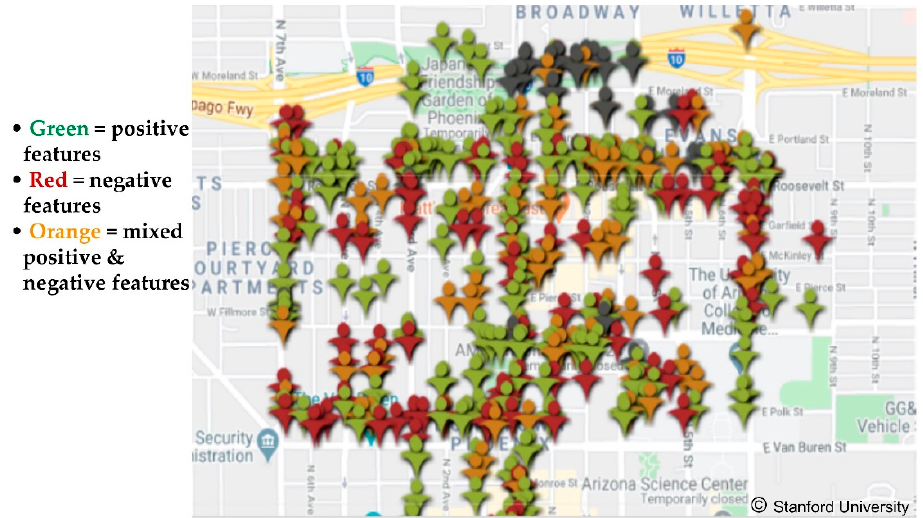
Figure 5. Example of discovery tool geocoded citizen science data grouped by location to identify community “hot spots”.